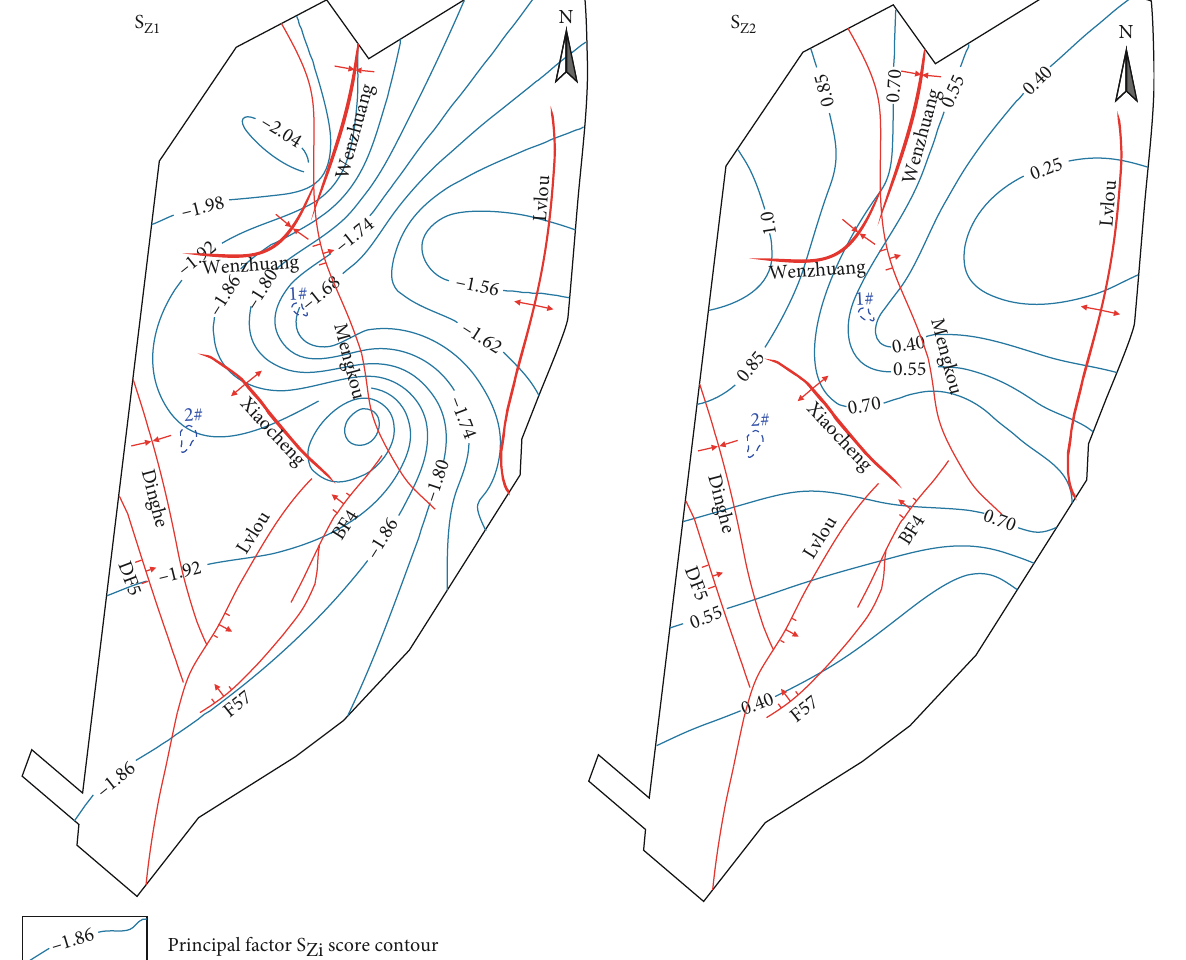
S Z 1 , Z 2 for Cenozoic